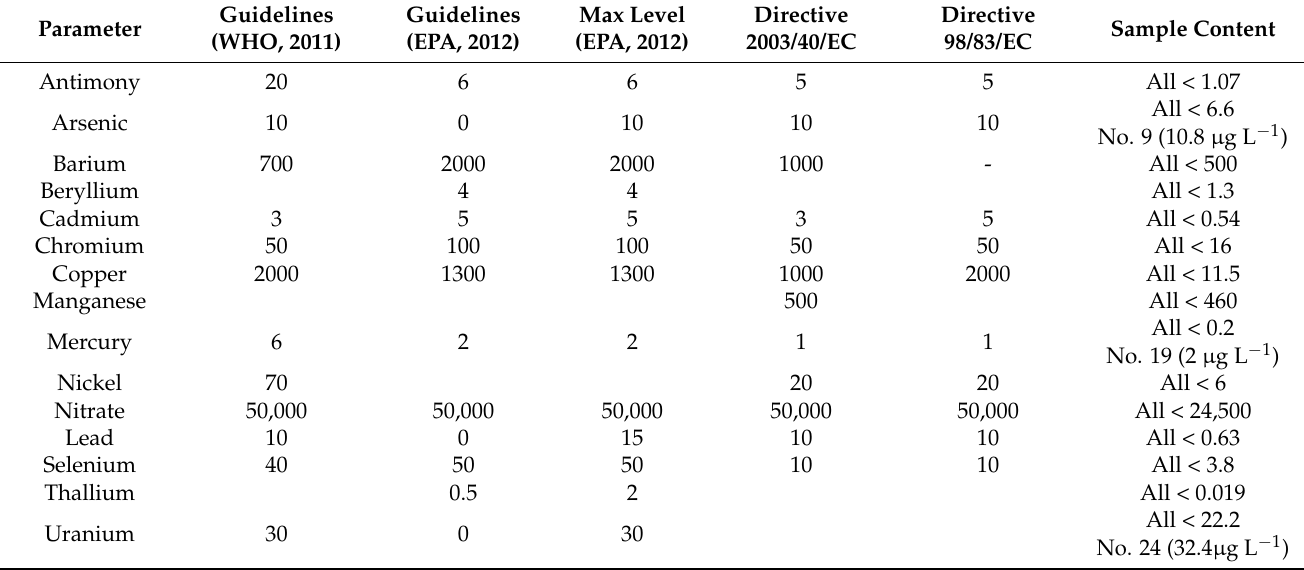
Figure 7. Box plots for trace elements in the sampled mineral waters ( n = 29 samples). Boxes correspond to the inter-quartile range of the distribution, whiskers correspond to no more than 1.5 times the inter-quartile range, and outliers are shown as black open circles. EPA standards (MCL) are the maximum concentration level, and (MCLG) represents the maximum concentration level goal. Table 3. Comparison between the concentration limits, according to the Commission Directive 2003/40/EC, the Drinking-Water Directive, WHO guidelines, and EPA standards (units in micro- grams per litre/ µ g L − 1